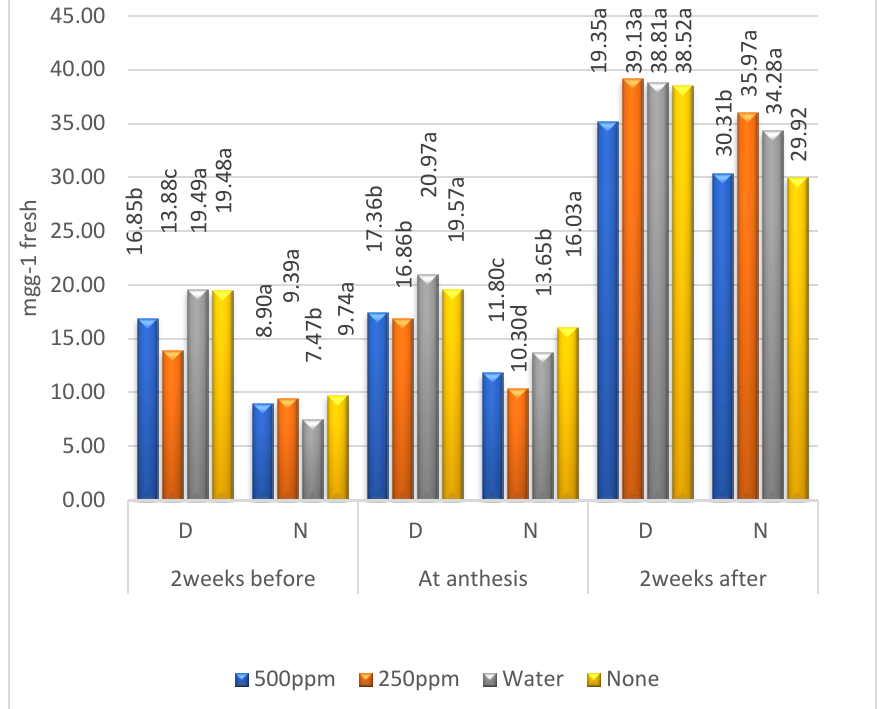
Figure 1. Combined means of soluble sugars for the levels of zinc under drought stress (D) and irrigation (N); means followed by the same letter in each environment are not significant at the 0.05 level of probability according to LSD test.